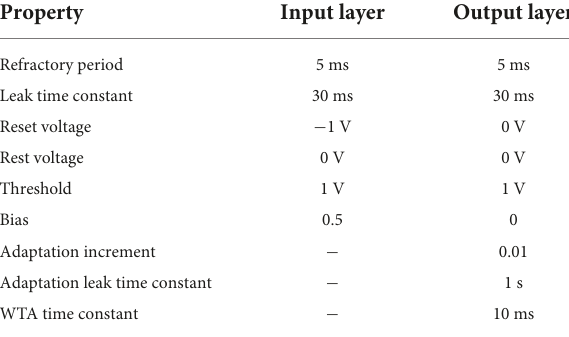
TABLE 1 Parameters of LIF input and ALIF output neurons used in this